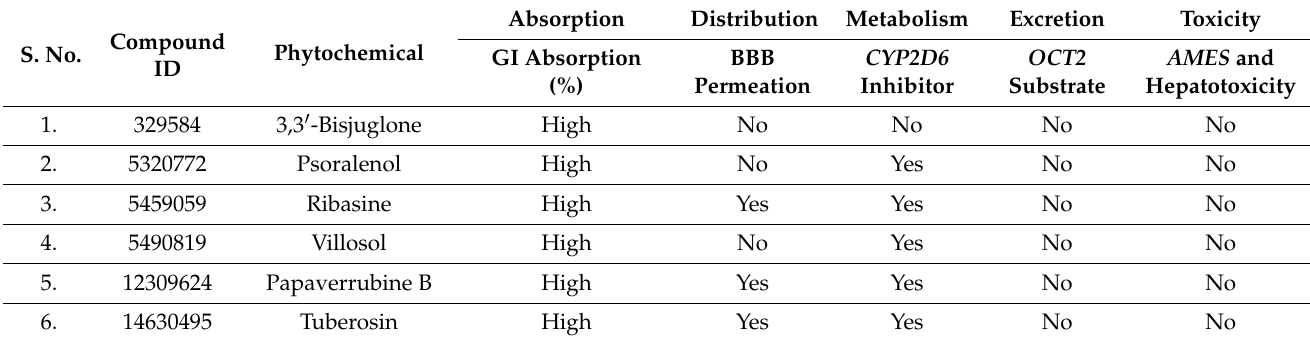
Table 2. ADMET properties of the selected compounds.